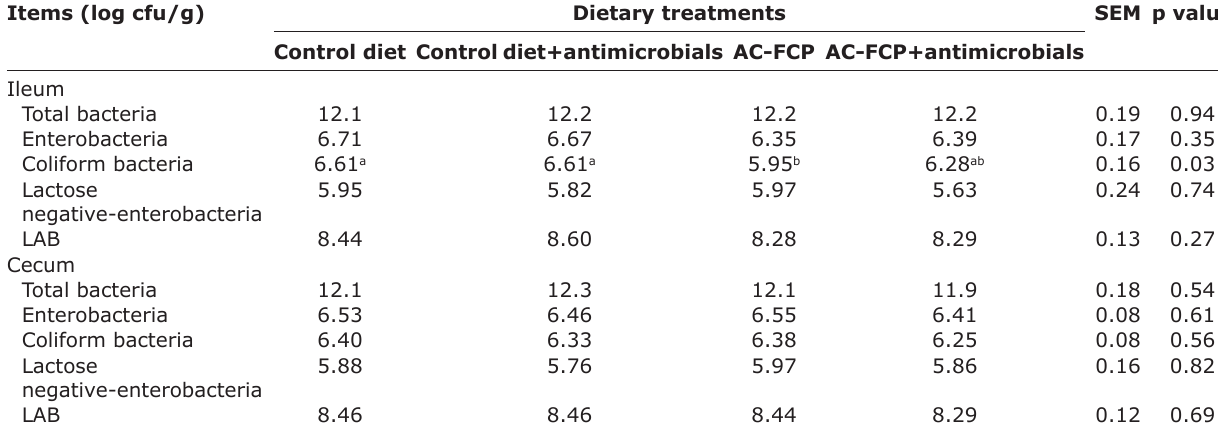
Table-2: Microbial population in the ileal and cecal digesta of broilers fed the treatment diets. Items (log cfu/g)